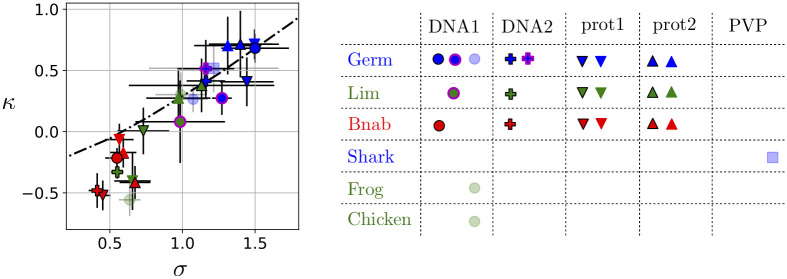
Shape parameter κ from fits of the enrichments to generalized Pareto distributions versus σ from fits to log-normal distributions.Results from different libraries selected against different targets are represented here with the same convention as in Fig 2: blue, green and red plain colors for the Germ, Lim and Bnab libraries, circle, cross, downward and upward triangles for the DNA1, DNA2, prot1 and prot2 targets. In addition, results from our previous work [16] are indicated in transparent blue if they involve a library built onto a germline scaffold and in transparent green if they involve a library built onto a maturated scaffold. The hierarchy indicated by κ is essentially the same as the hierarchy indicated by σ, consistent with the expected relationship between κ and σ (black dotted line, S14 Fig). By the two approaches, libraries built onto germline scaffolds are found to have a more diverse response to selection than libraries built onto maturated scaffolds irrespectively of the target (all values of σ and κ are given in S1 Table).